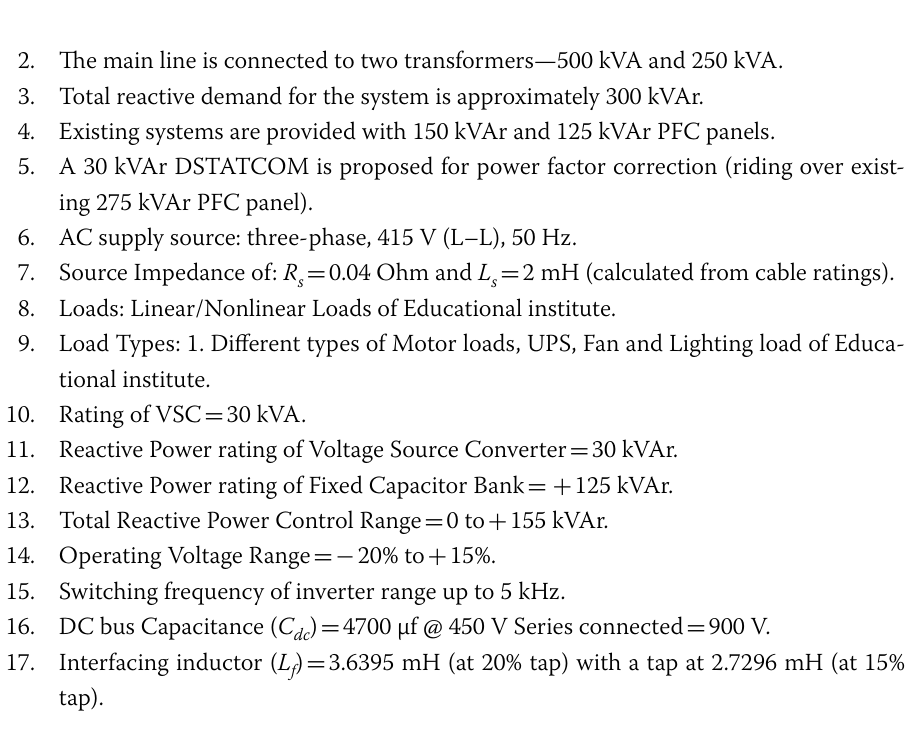
Fig. 12 Flowchart of coordinated control (SCB